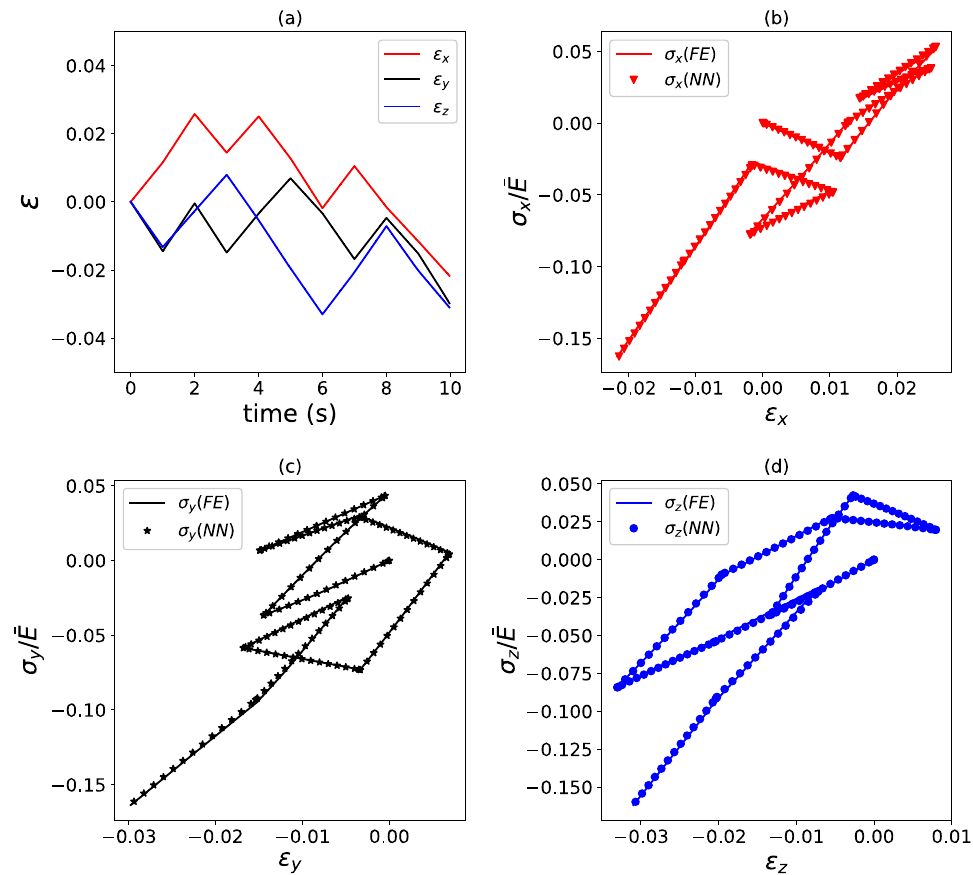
Figure 9. Example of strain versus time ( a ) and stress versus strain ( b – d ) histories for an elastic–plastic composite with κ = 2.0 . FE predictions are compared to predictions by a surrogate model. E σ = 2.7% for the load case shown, which used φ = 5000 training data